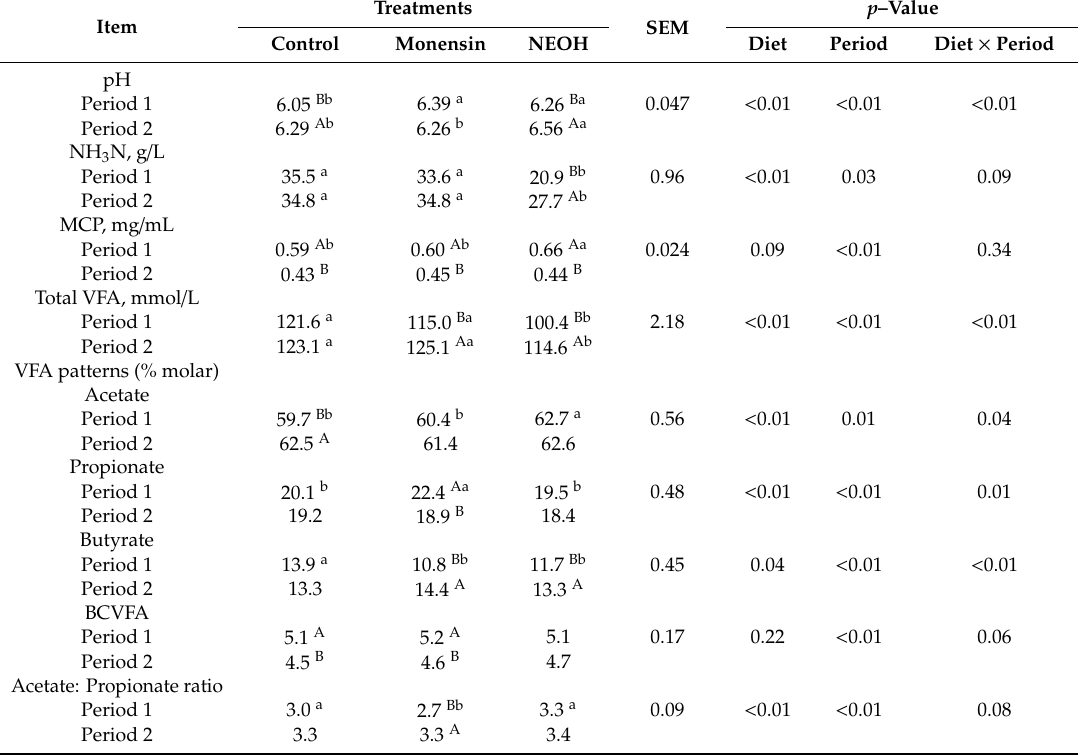
Table 4. Supplementation e ff ects of monensin and nitroethanol (NEOH) to lamb diet in feeding period 1 (day 0–16) and their withdrawn e ff ects in subsequent period 2 (day 17–32) on rumen fermentation